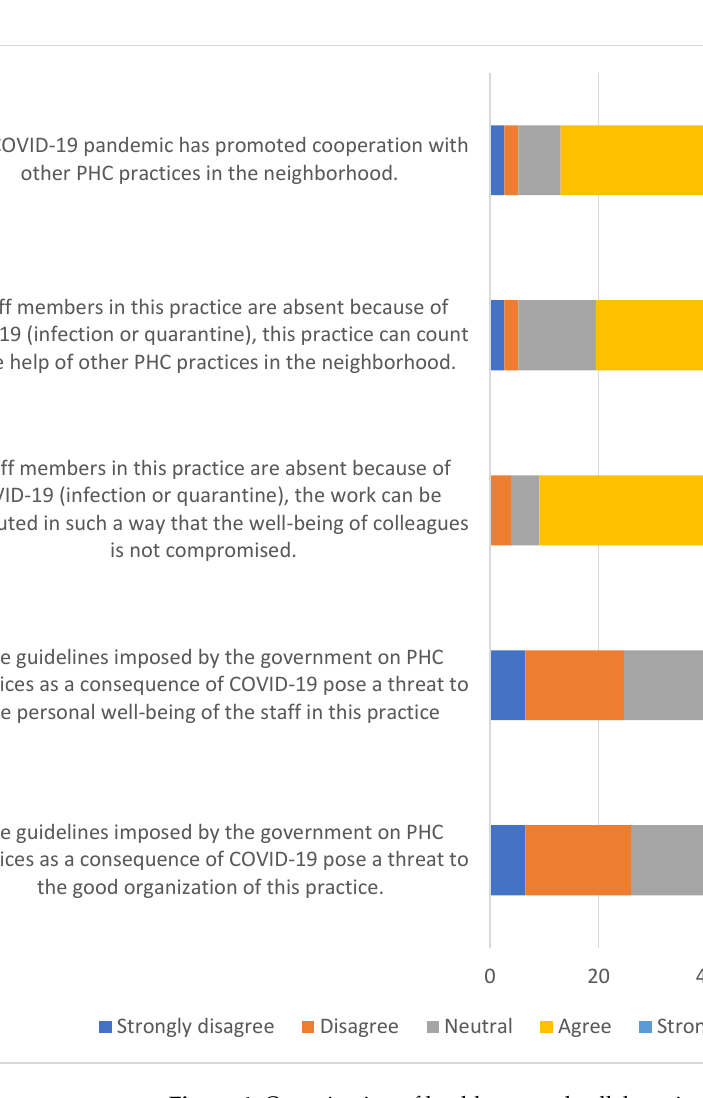
Figure 4. Organization of healthcare and collaboration between PHC practices to deliver healthcare services for patients during COVID-19.